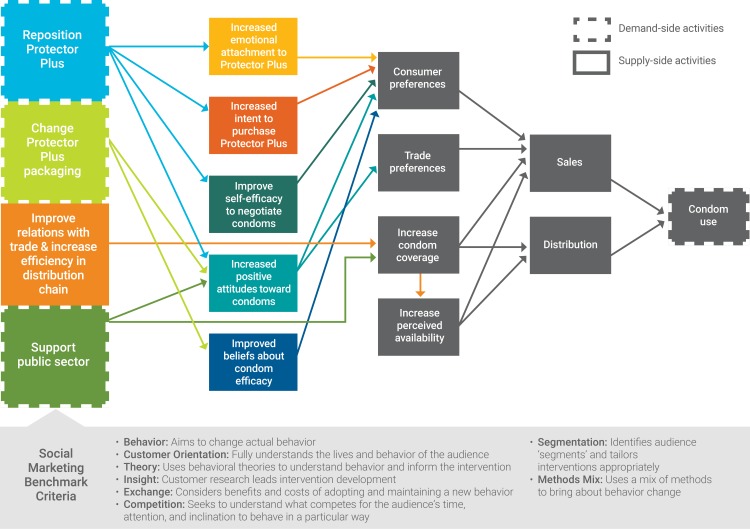
Theory of change.